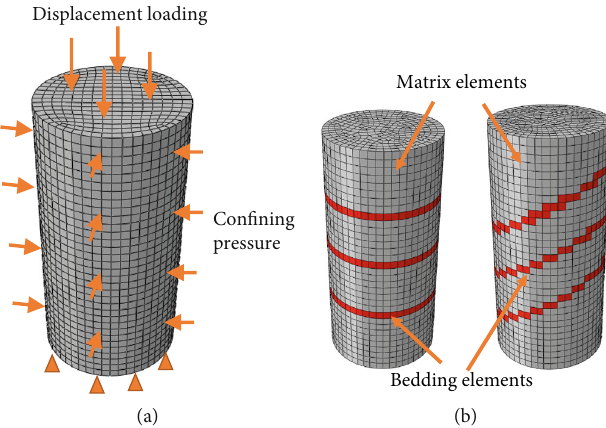
Figure 9: Finite element model con fi guration and load method for triaxial